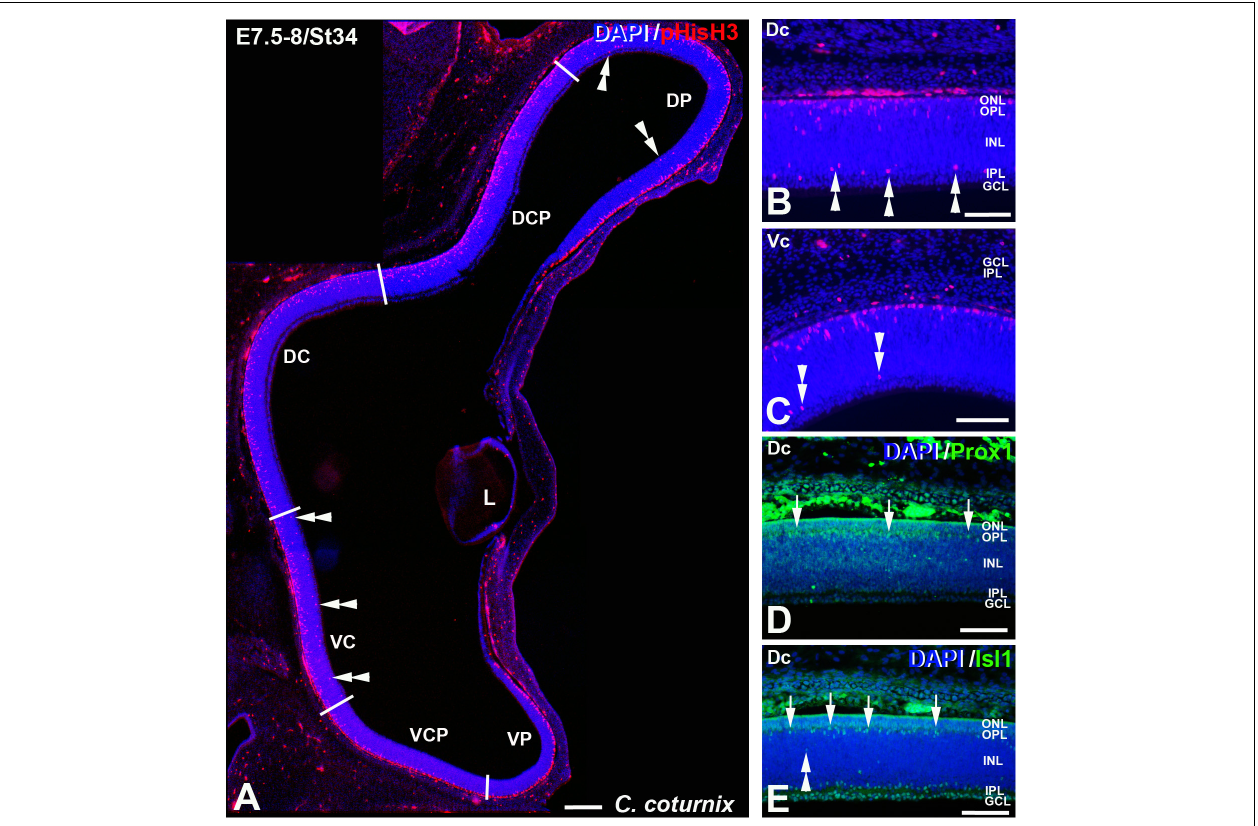
FIGURE 9 | pHisH3 (A–C) , Prox1 (D) , and Isl1 (E) immunolabeling in the C. coturnix retina at E7.5-8 (St34). Cryosections were counterstained with DAPI. (A–C) Non-apical mitosis were mainly located in the D retina but also in the Vc sector (double arrowheads). (D,E) Abundant Prox1- and Isl1-immunoreactive horizontal cells were detected in the horizontal cell layer of the Dc sector (arrows). Abbreviations: GCL, ganglion cell layer; INL, inner nuclear layer; IPL, inner plexiform layer; L, lens; ONL, outer nuclear layer. Scale bars: 100 µ m in panel (A) ; 50 µ m in panels (B–E)